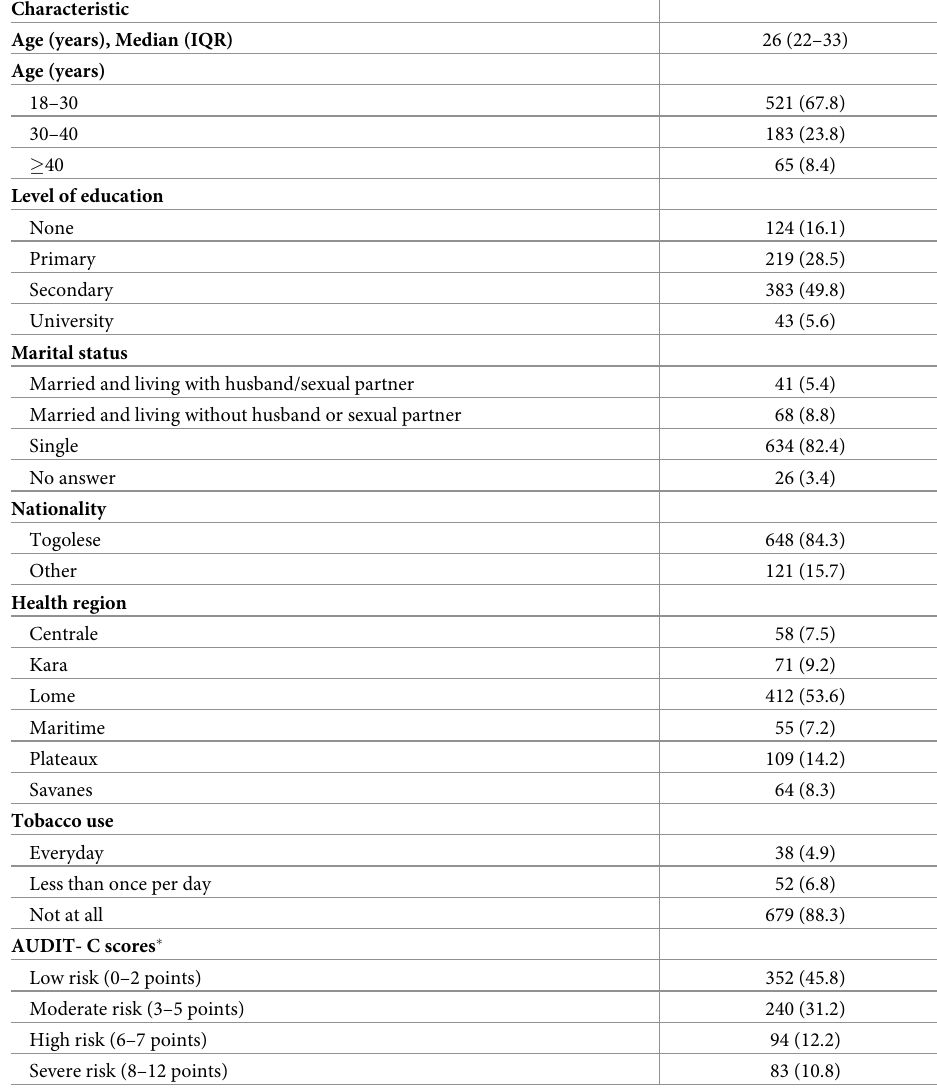
Table 1. Sociodemographic characteristics among female sex workers in Togo in 2017 (N = 769).